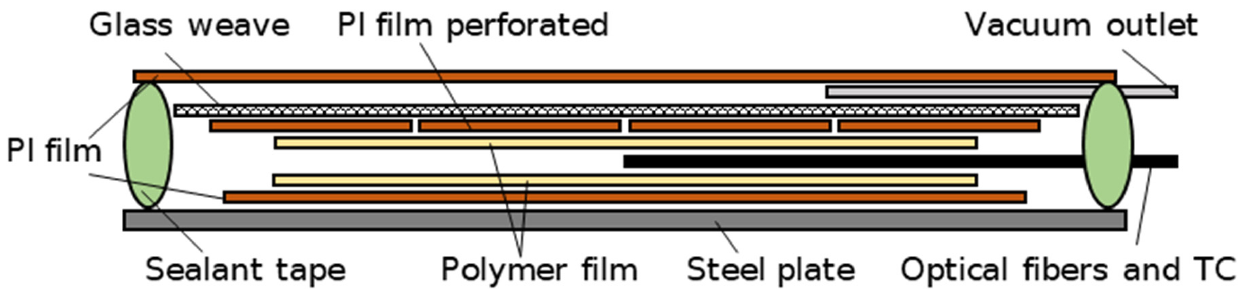
Figure 2. Schematic representation of the experimental vacuum bagging setup. TC refers to the thermocouple.